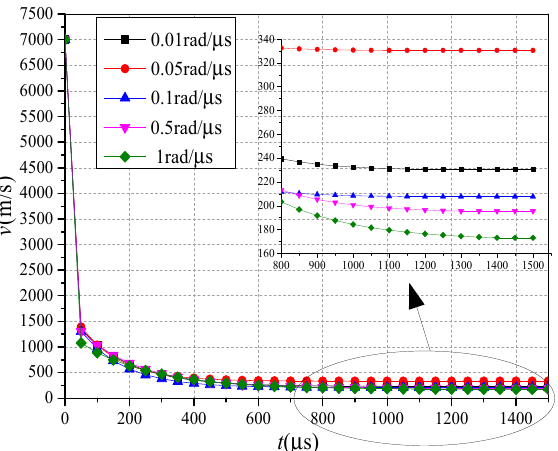
Figure 17. Attenuation curves of the translation velocity when the debris impacted the satellite tank with angular velocities of w x = 0.01 rad / µ s, w x = 0.05 rad / µ s, w x = 0.1 rad / µ s, w x = 0.5 rad / µ s, and w x = 1 rad / µ s.